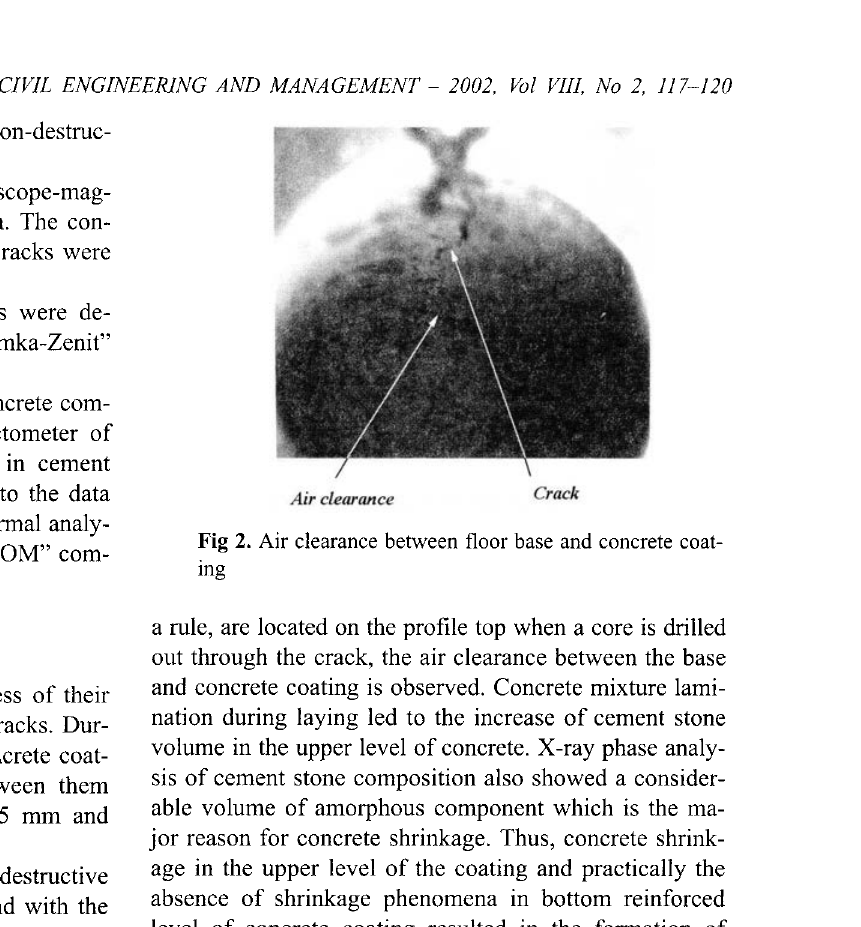
Fig 3. Concrete coating profile in crack area